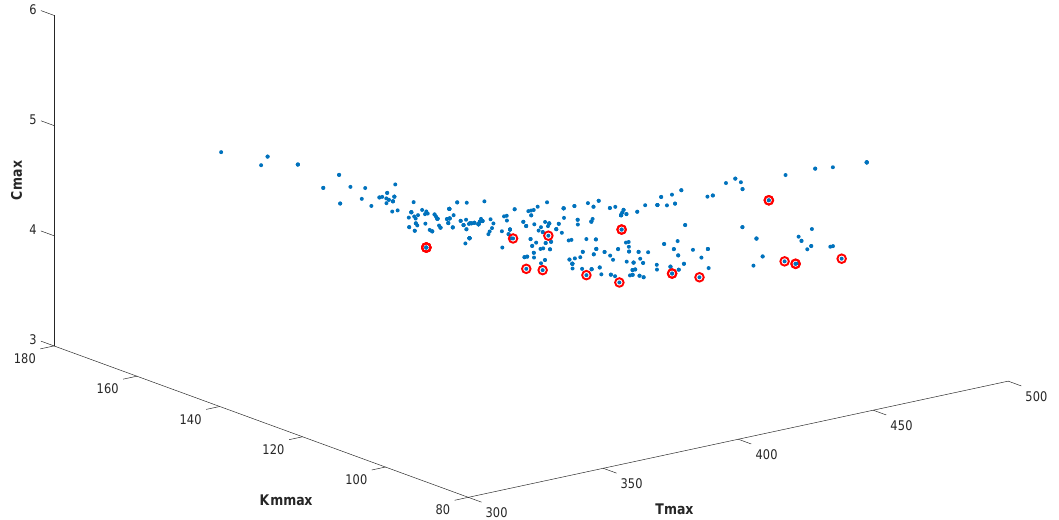
Figure 4. Pareto front with non-dominated (red circle) versus dominated solutions (blue points). Table 6. Values of the non-dominated solutions for the three objectives. #Sol. Tmax Kmmax